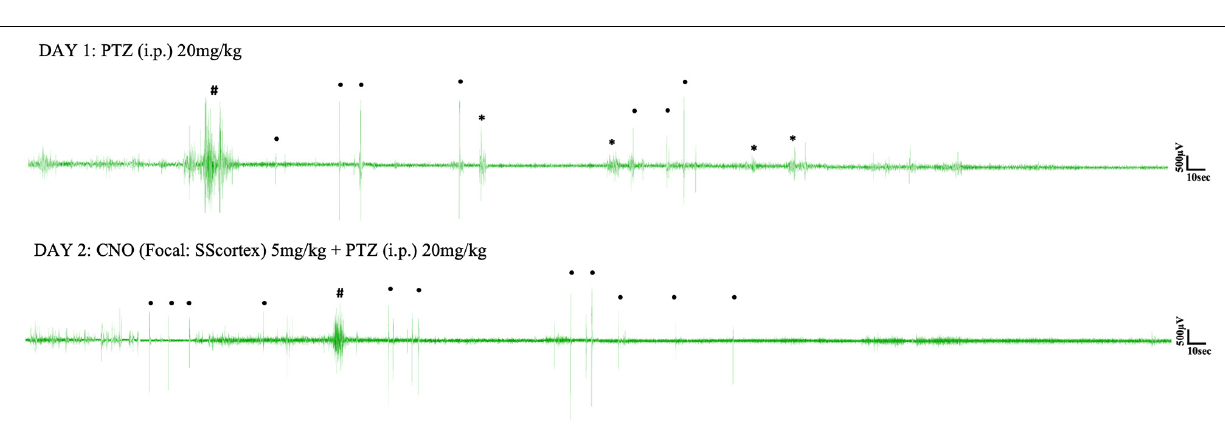
FIGURE 5 | Representative EEG traces from a PV Cre /Gq-DREADD animal after i.p. PTZ injection on day 1 and focal (SScortex) CNO and i.p. PTZ injection on day 2. Asterisks ( ∗ ), hash signs (#), and dot signs ( • ) represent absence-like, tonic-clonic and other types of seizures, respectively. Each trace represents 10 min of EEG